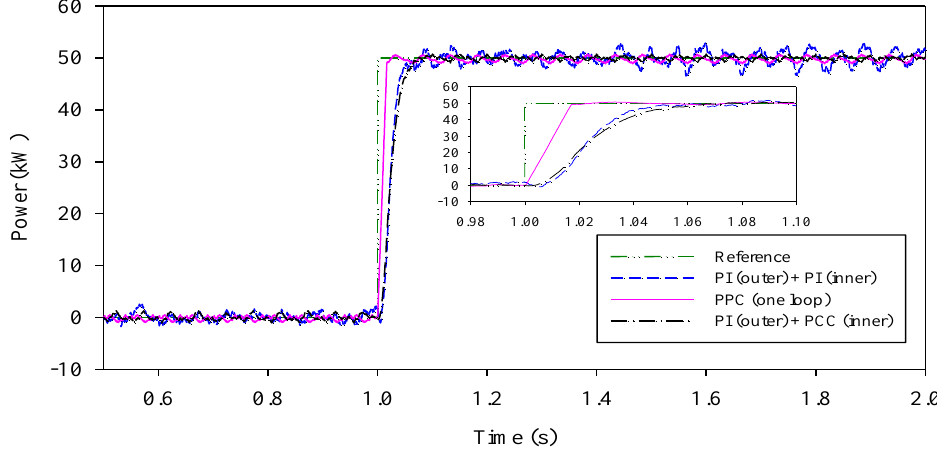
Figure 5. Response of different control techniques for change in reference power.